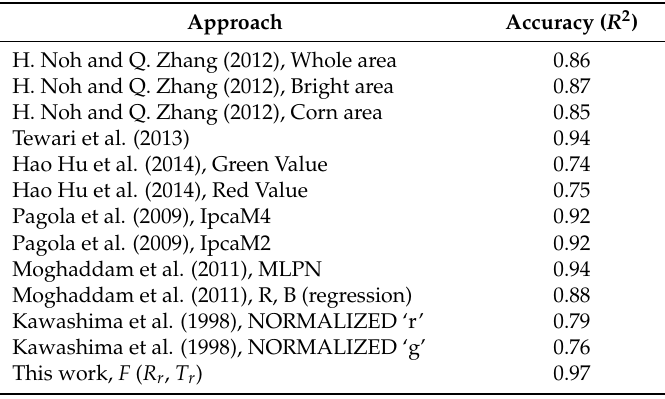
Table 5. Vision-based approaches for chlorophyll content